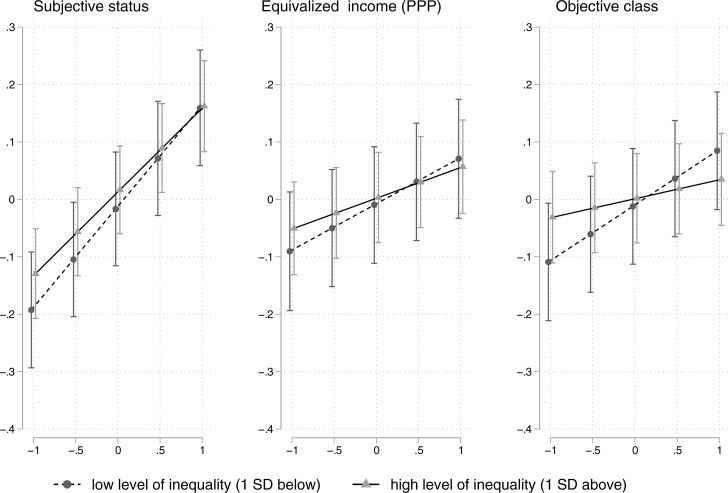
Predicted values of entitlement derived from the models in Table 3.Estimates were calculated for five equally spaced values of our respective class measure (ranging from 1 SD below to 1 SD above average) and for high and low levels of inequality (±1 SD respectively).